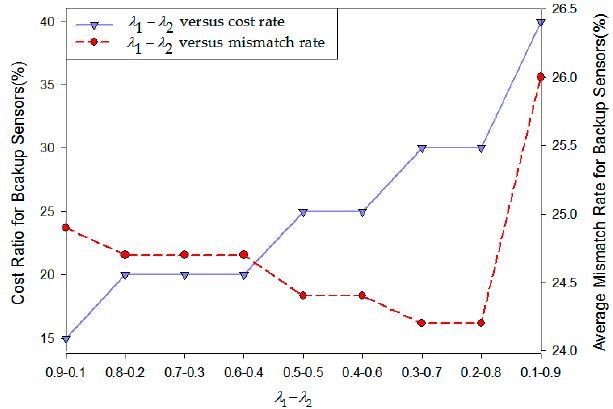
Figure 14. Backup sensor deployment cost ratio and average mismatch rate with different values of λ 1 , λ 2 .